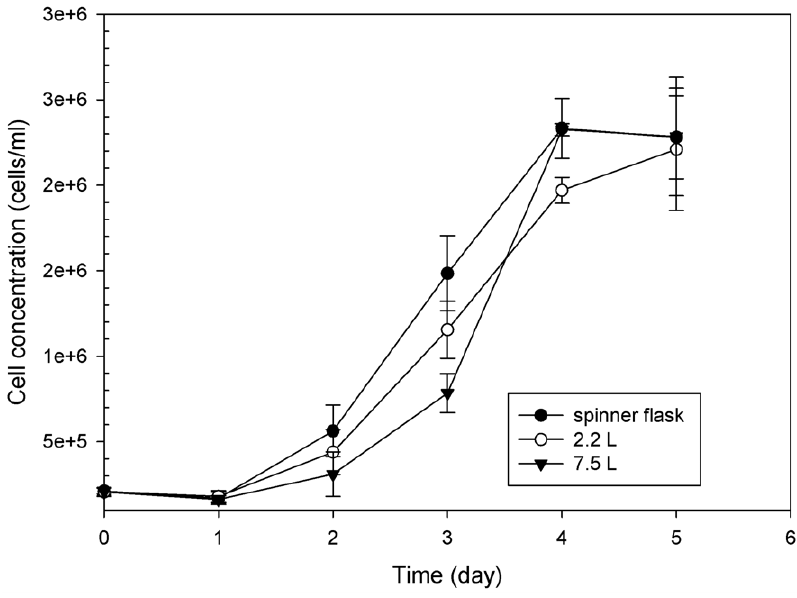
Figure 2. The growth of MDCK cells on microcarrier in each cultured system. MDCK cells were grown either in the 125 mL spinner flask, or 2.2 L or 7.5 L bioreactors with 5 g/L of Cytodex 1 microcarriers. Cell densities were measured on each day and found to increase more than 10-fold from an initial concentration of 2.0 6 10 5 cells/ml to confluency at 2.3 6 10 6 cells/ml after 5 days. The cell growth in various bioreactors did not show any significant difference of cell density based on the student t-test.